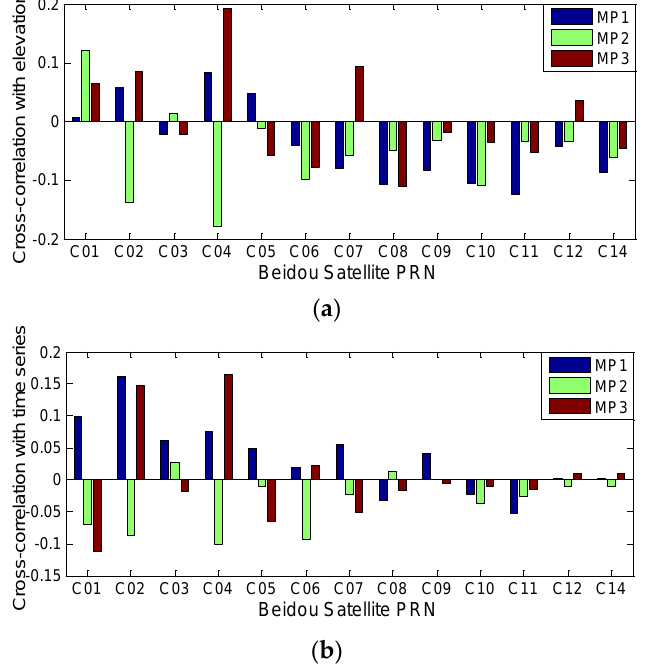
Figure 2. The Spearman cross-correlations between multipath estimations with elevation ( a ) and time series ( b ) at station CUT0.